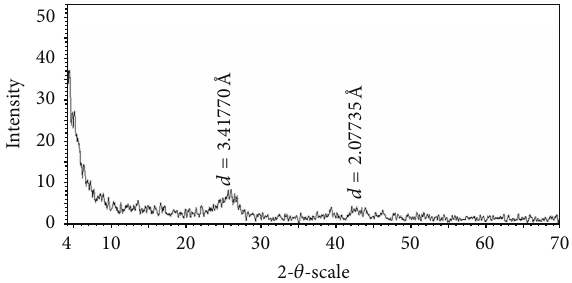
Figure 2: X-ray diffraction patterns of the pristine